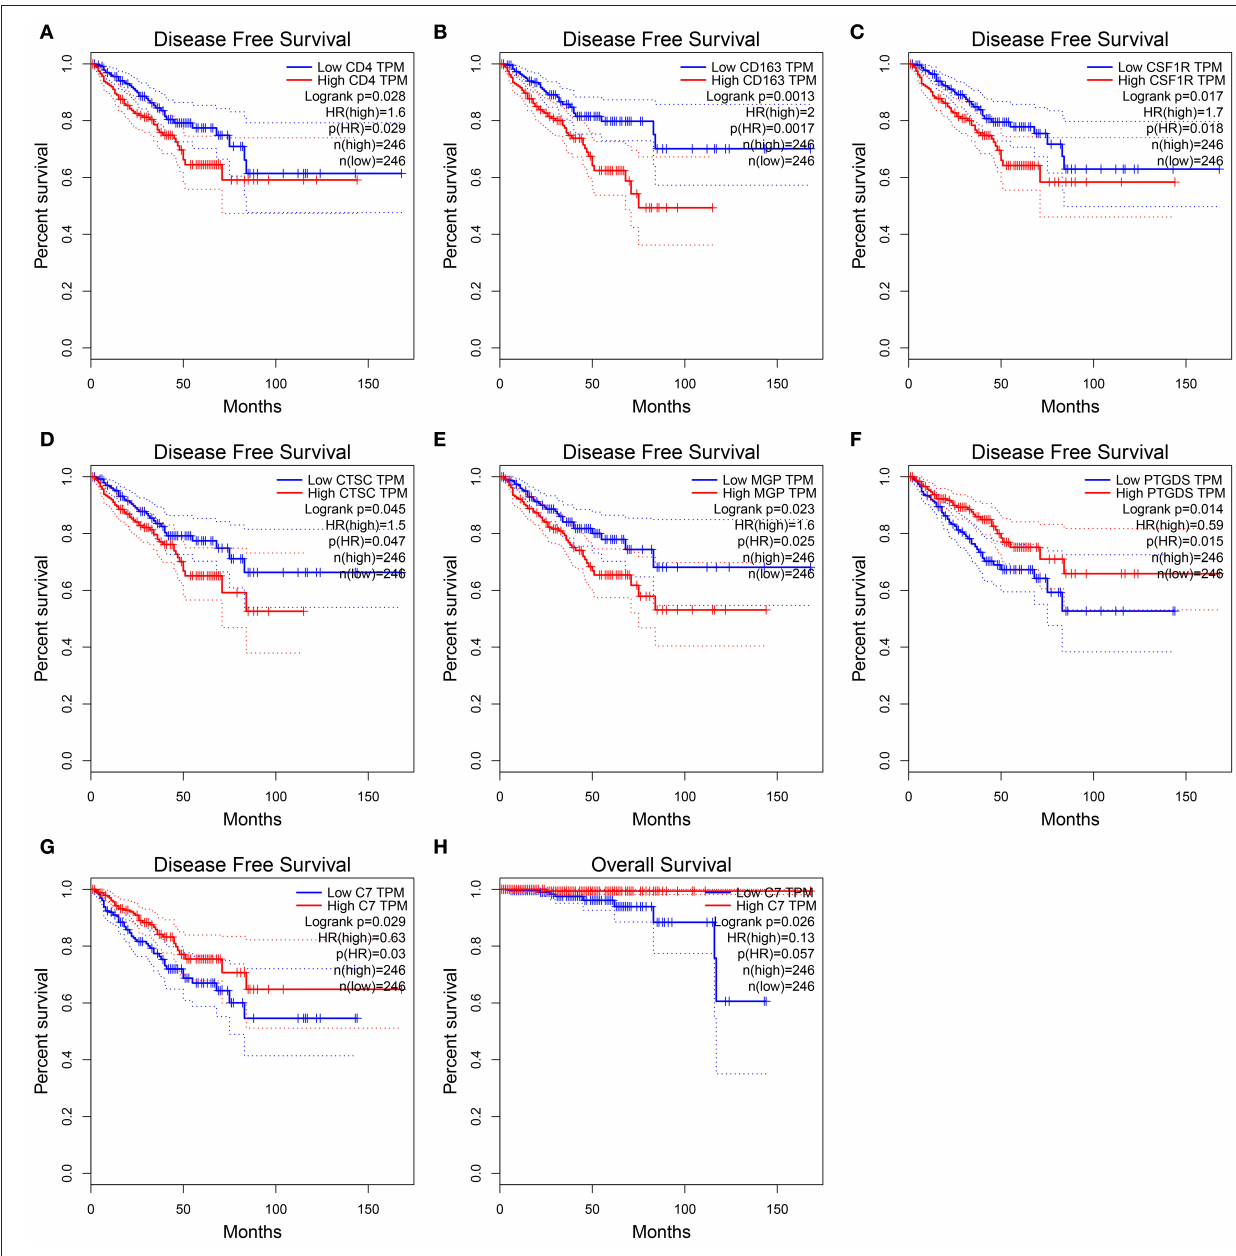
FIGURE 5 | Disease-free survival analyses on CD4 (A) , CD163 (B) , CSF1R (C) , CTSC (D) , MGP (E) , PTGDS (F) , C7 (G) based on the TCGA-PRAD data. Overall survival analyses on C7 (H) based on the TCGA-PRAD data.